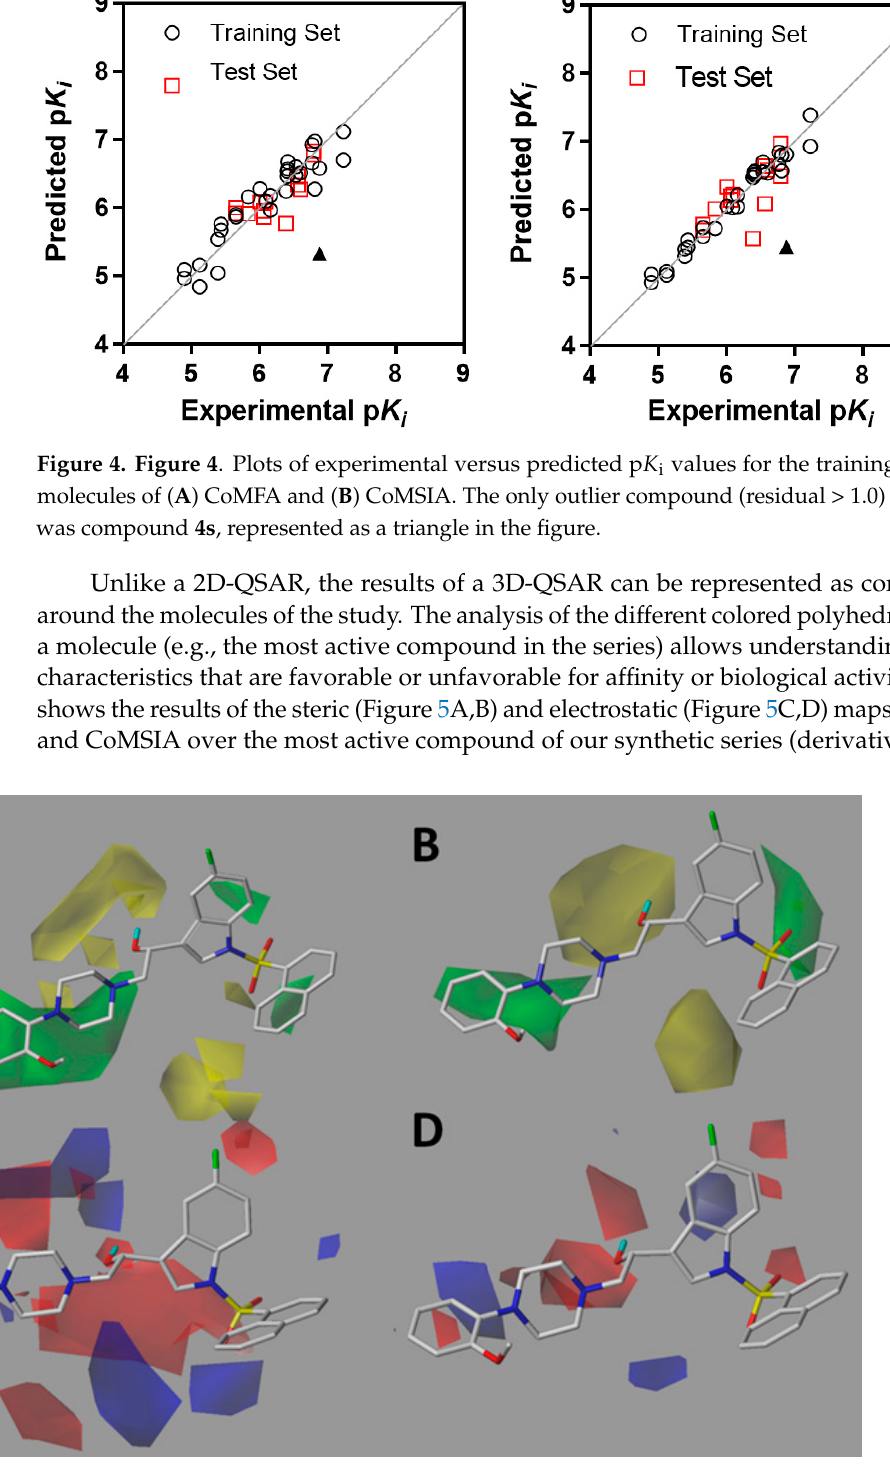
Figure 5. Graphics results of the CoMFA and CoMSIA studies. ( A ) CoMFA steric contour map for Table 4. 4d (p K i = 7.234) and ( B ) CoMSIA steric contour map. Green polyhedrons indicate that it is favorable for biological activity to use bulky substituents, while yellow polyhedrons indicate that it is not favorable. ( C ) CoMFA electrostatic contour map for the most active molecule 4d and ( D ) CoMSIA electrostatic contour map. Blue polyhedrons indicate that the presence of electron-deficient zones is favorable for activity, while red polyhedrons indicate that electron-rich zones are favorable.